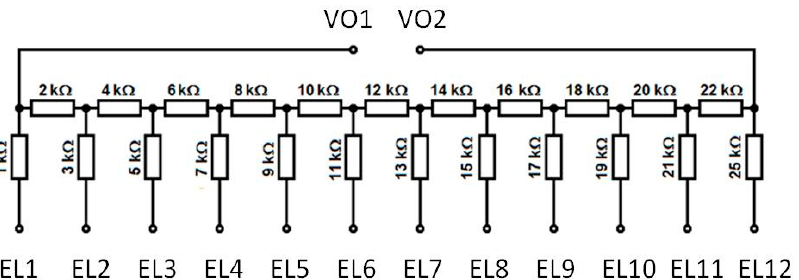
Figure 16. Resistance circuit created for the dodecahedron sensor illustrated in Figure 12b: EL1–EL12, electrodes of the sensor; VO1–VO2, analog voltage outputs.